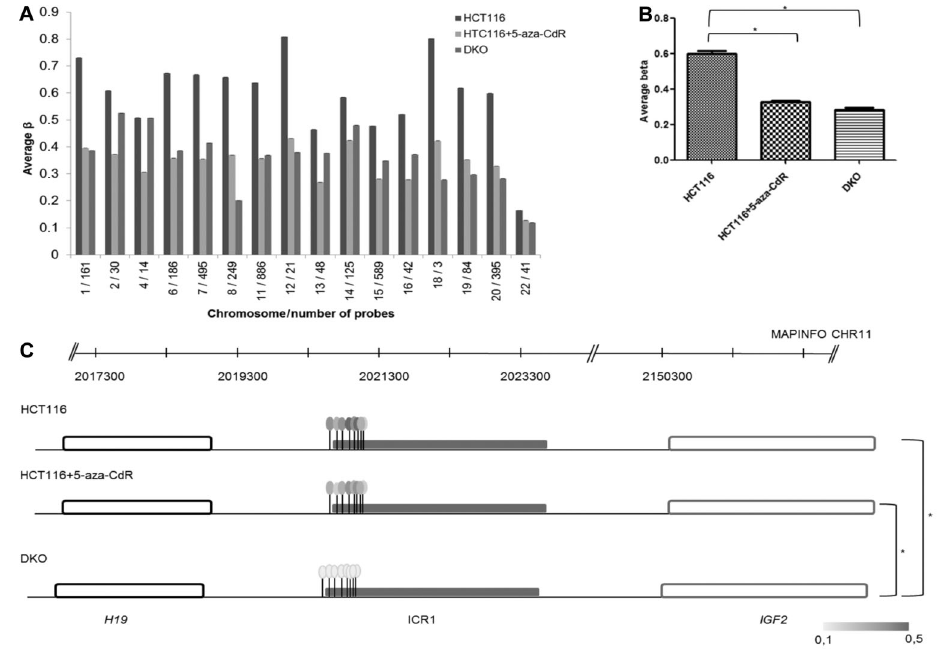
Figure 2. DNA methylation profile of CpGs (cytosine-phosphate-guanine) related to imprinted genes. A , The graph shows the DNA methylation level of CpG sites related to imprinted genes covered in the 450K platform, arranged per chromosome ( b values average ranging from 0 to 1, unmethylated and fully methylated, respectively). Chromosomes 2, 4, and 8 presented methylation levels after 5-aza- CdR treatment different from DNMTs disruption (DKO cells; P , 0.0001). B , Global DNA methylation level of all imprinted genes analyzed in the different cell lines.DKO and 5-aza-2 9 -deoxycytidine(5-aza-CdR)-treated cells exhibited statisticallysignificant demethylation compared to HCT116 cells. C , Schematic view of the ICR1, the imprinting center of IGF2 and H19 genes, and the range of DNA methylation level of 8 CpGs sites (ovals) analyzed in this region (cg00237904, cg06765785, cg25821896, cg25574978, cg18454954, cg25579157, cg02886509 and cg02657360). The color-ratio bar at the bottom indicates the methylation level. DKO cells DNA methylation profile was retrieved from Gene Expression Omnibus: GSE29290, sample GSM815139. *P , 0.05, Kruskal-Wallis test with Dunn’s multiple comparison post hoc